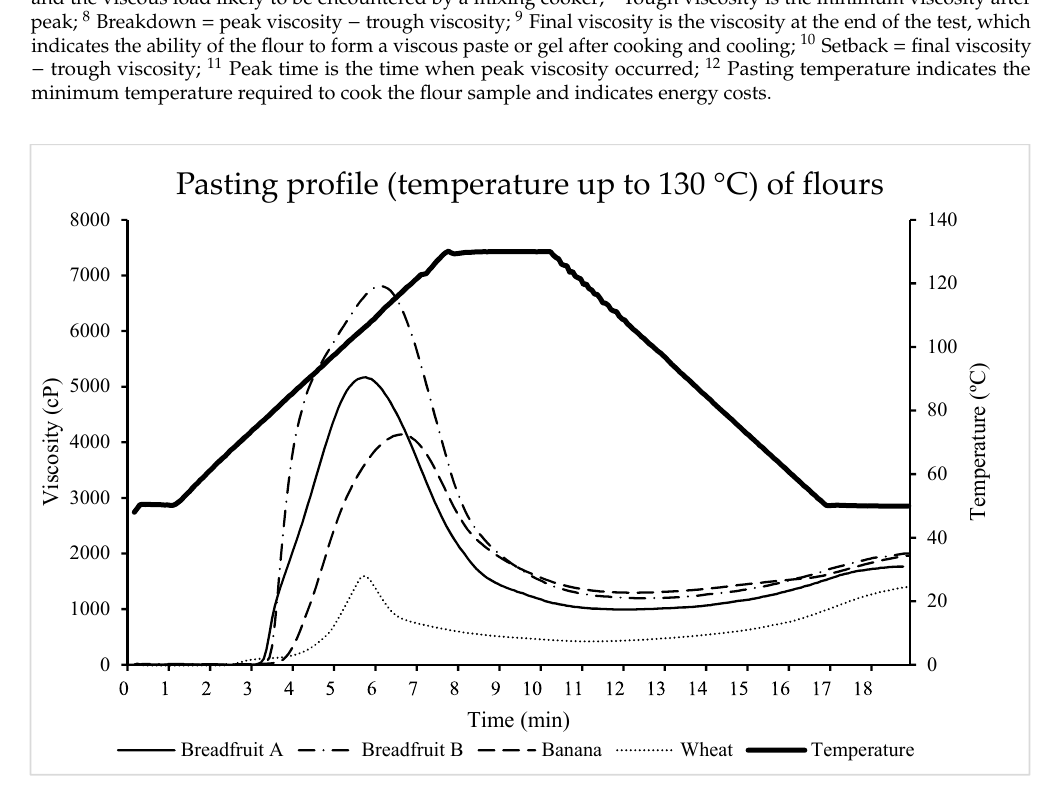
Table 5. The pasting properties of tropical flours compared with a traditional flour using RVA method #2 (maximum temperature of 130 °C). 1.